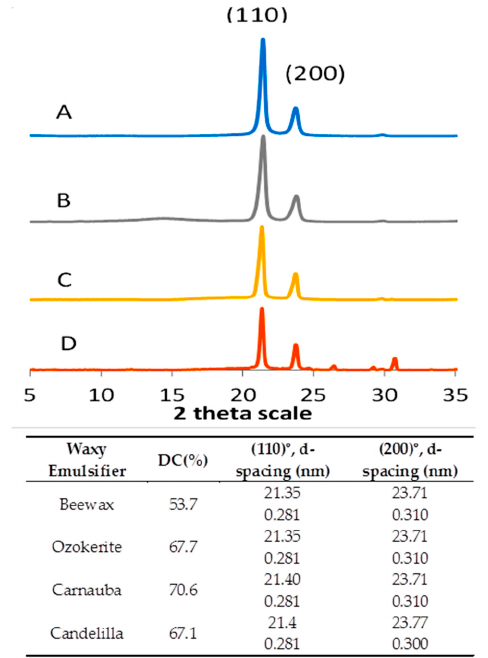
Figure 1. Wide angle X-ray di ff raction for waxy emulsifiers. ( A ). carnauba wax, ( B ). candelilla wax, ( C ). beewax, ( D ). ozokerite wax, ( DC ). Degree of